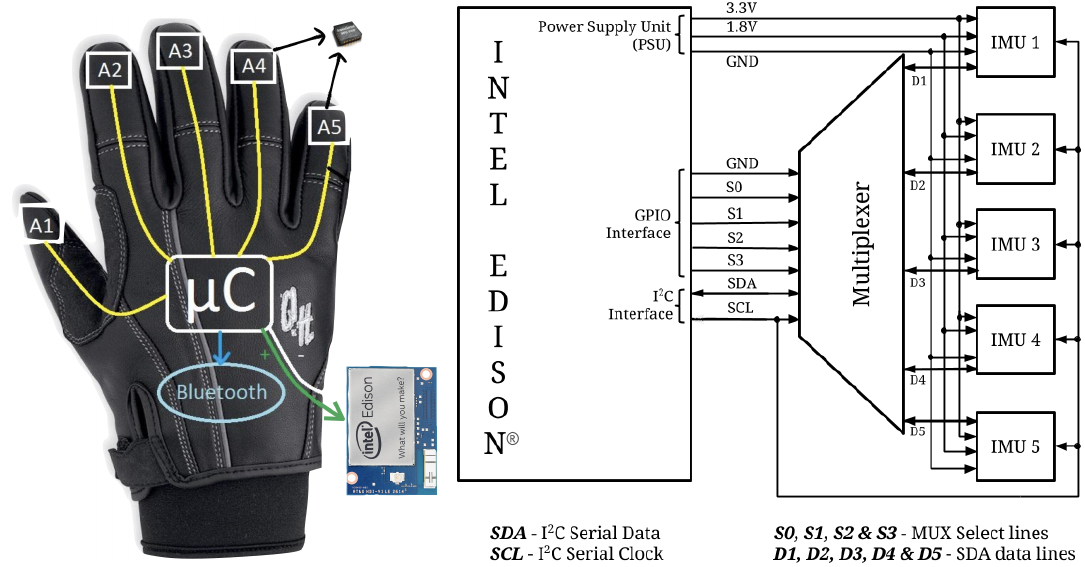
Figure 2. ( Left ): The presented prototype, equipped with Intel’s Edison module, connects serially with five IMUs at all finger tips that are bridged with a multiplexer. The glove has a 1000 mAh rechargeable battery that lasts at least 8 h with both processors, Bluetooth and WiFi on. ( Right ): The hardware design of the system, showing the combination of the Edison module and five IMU sensors, through the I 2 C interface bus. Connections for the IMU are as follows: VCC —3.3 V, V LOGIC —1.8 V, SDA ,